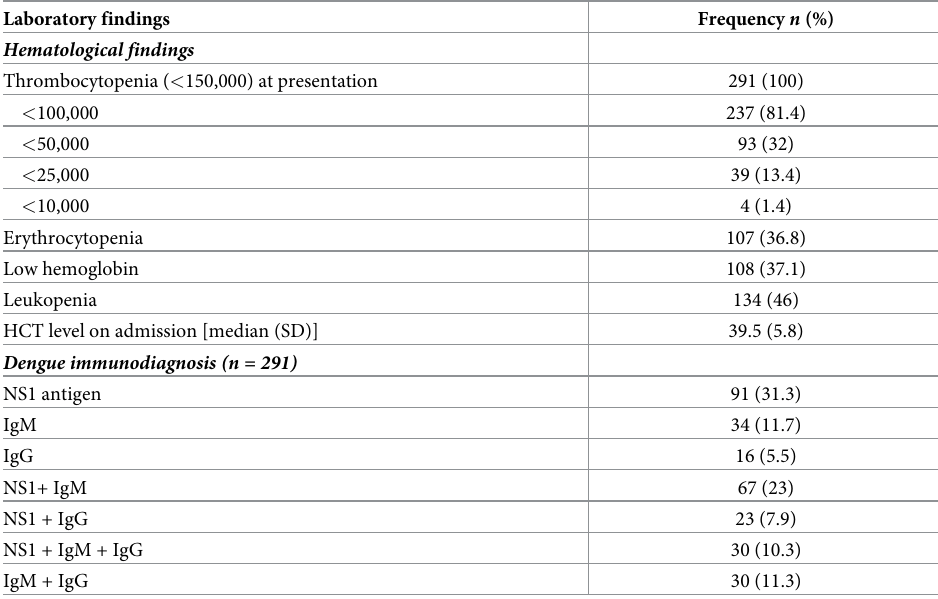
Table 3. Laboratory findings of dengue patients reported from Lahore and Rawalpindi.